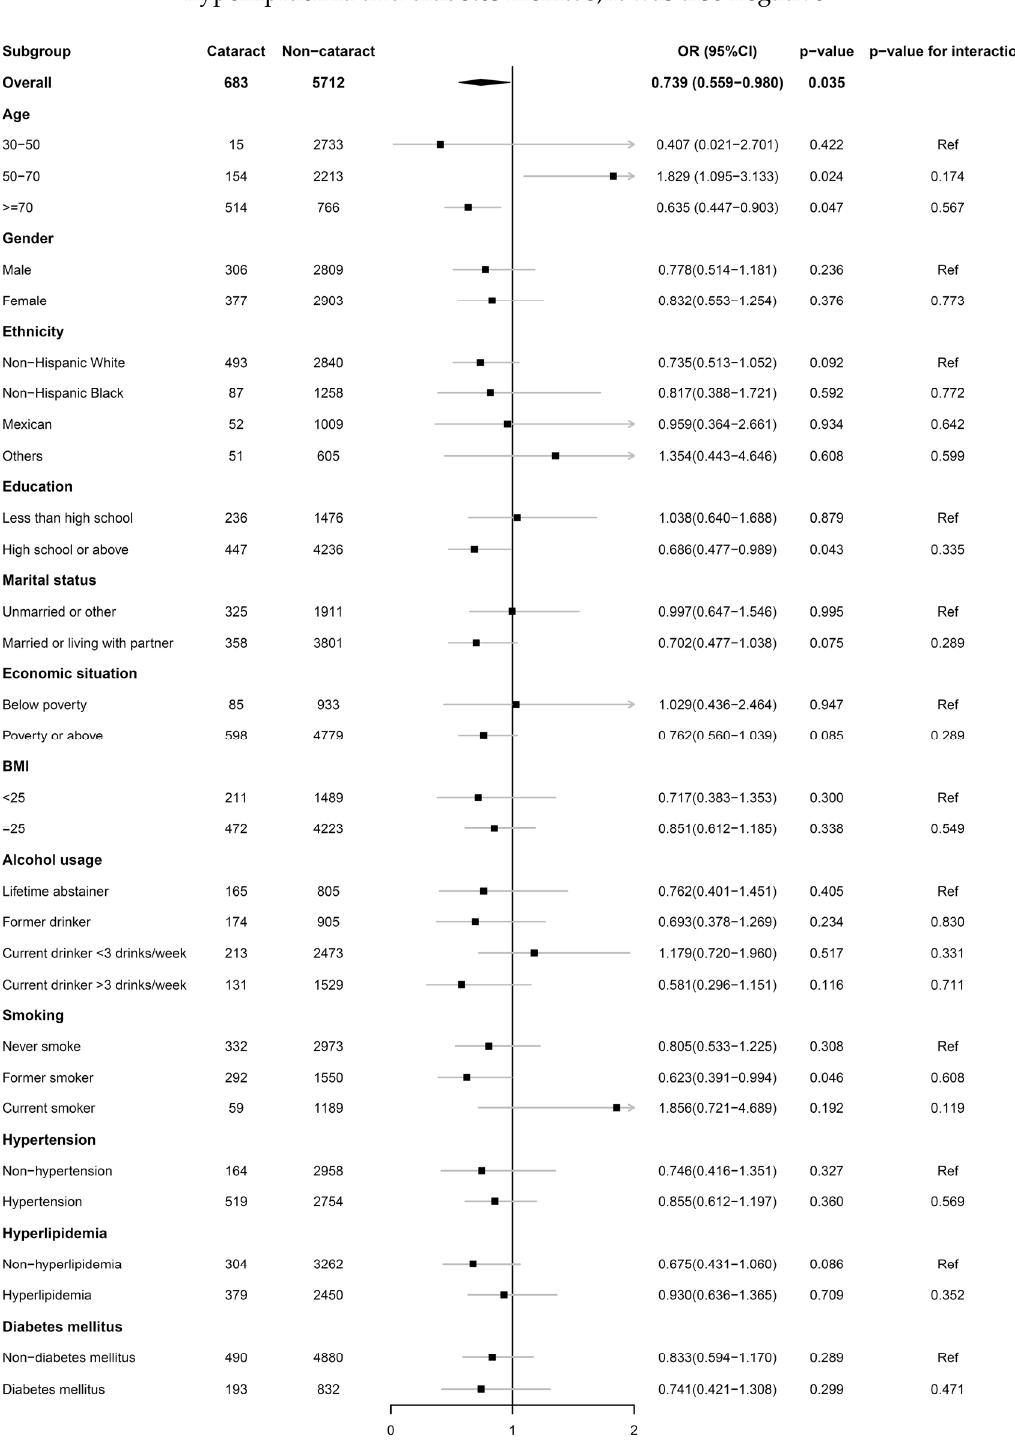
Figure 3. Subgroup analysis of the association of HEI-2015 with cataract.